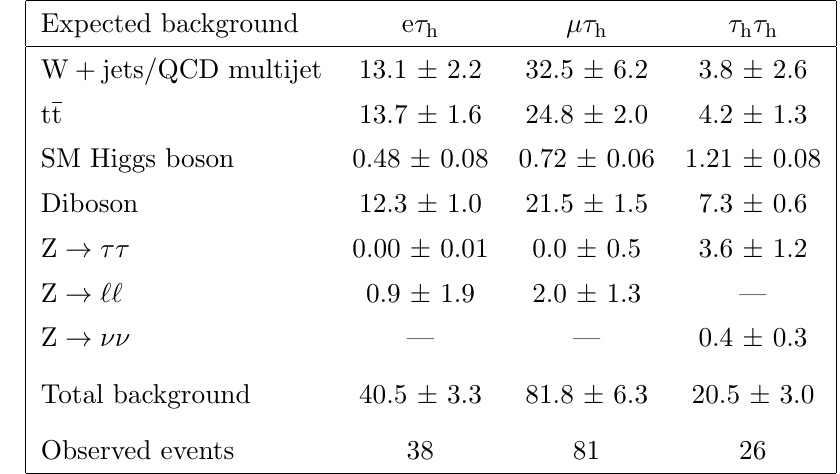
Table 6 . Estimated background yields and observed numbers of events for M tot SR of the h ! (cid:28) + (cid:28) channel. The uncertainties in the total expected yields include the statistical (cid:0) and systematic contributions.